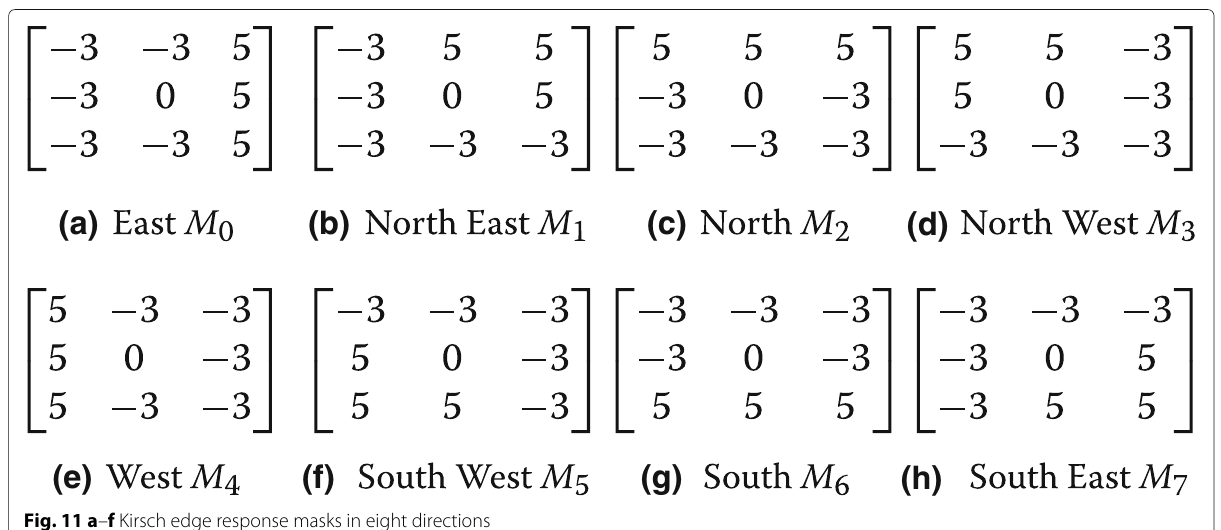
For k = 3, LDP operator generates C 8